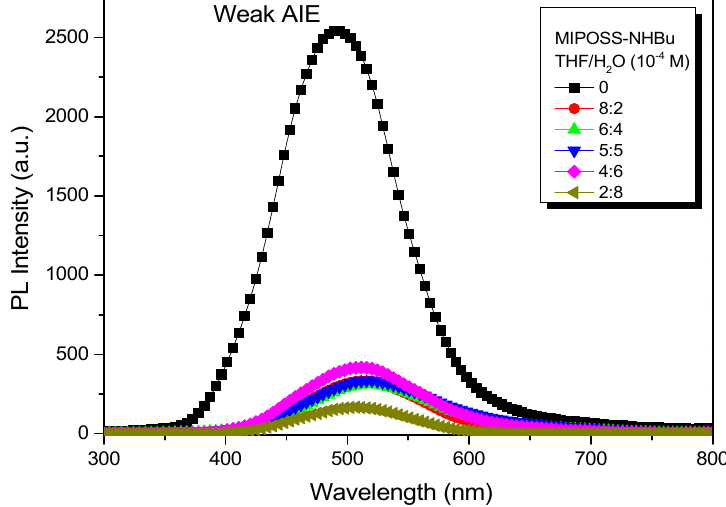
Figure 13. Fluorescence spectra of the monomer MIPOSS-NHBu, in THF/H 2 O at various ratios at a concentration of 10 − 4 M (excitation: 330 nm).